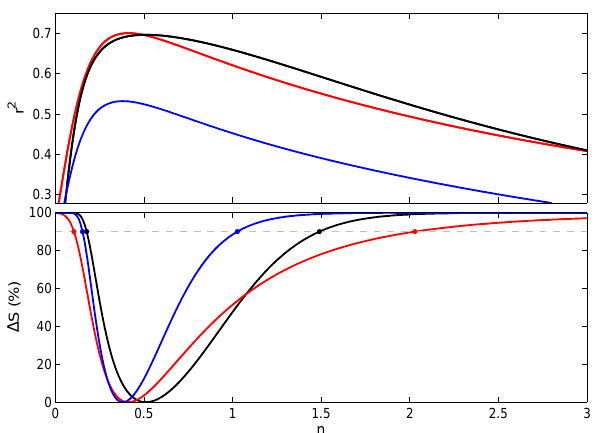
Fig. 8. (Top) Correlograms of group sunspot number, (to power n ) R n , against the IMF B for annual mean data. The square of the cor- G relation coefficient r 2 is shown as a function of n from 0 to 3 for: (in red) IMF observations (1964–2012, inclusive), (in black) the recon- structed IMF (1845–2012) from the IDV(1d) index, and (in blue) using modelled IMF (1611–2012). (Bottom) The significance 1S of the difference between the peak correlation and the correlation at a general n . The horizontal dashed grey line is the 90% significance level.